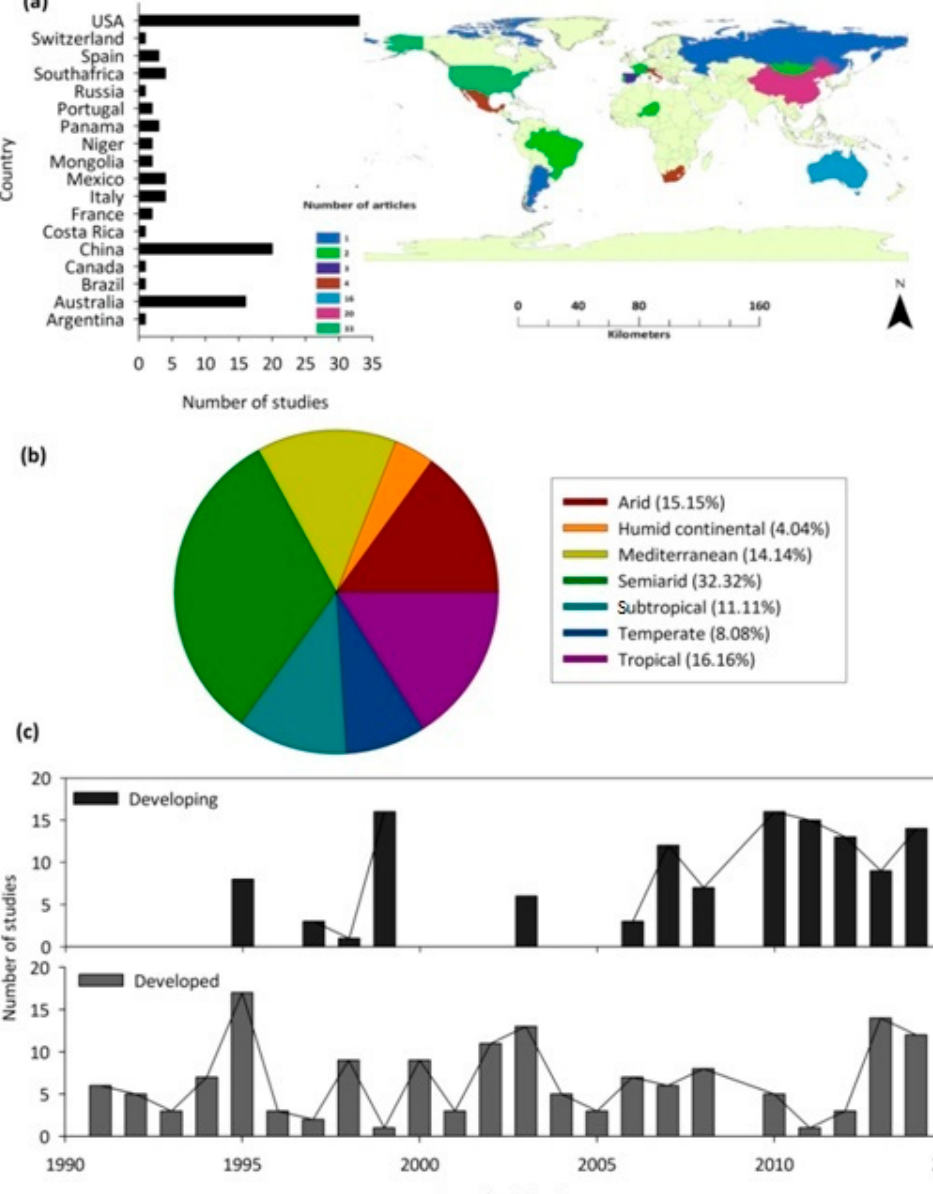
Figure 3. ( a ) The map and bar graph indicate the global distribution of publications on woody plant water source ( b ) The pie chart represents the proportion of publications on woody plant water source across different climatic regions ( c ) The publication trend (between 1970 and 2014) for research articles related to woody plant water source in forest areas in developed and developing countries (based on the United Nations World Economic Situations and Prospects classification).